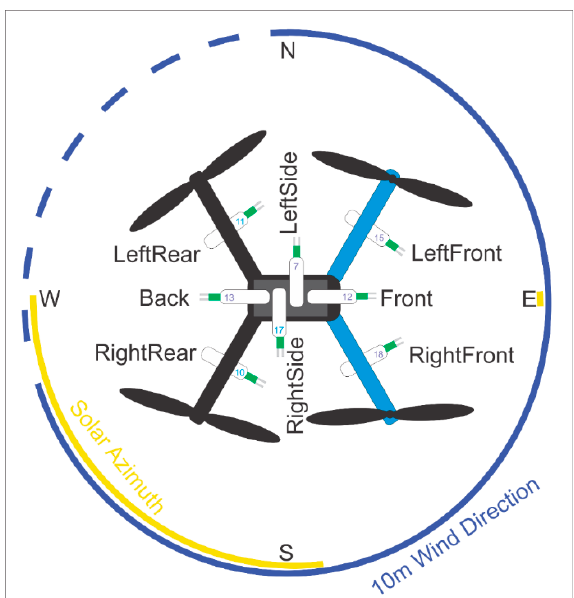
Figure 2. Schematic of the UAV in hover. Solar azimuth angles (yellow arc) range from 173.7 ◦ to 268.18 ◦ and from 88.87 ◦ to 89.87 ◦ . The 10 m wind direction ranges from 0 ◦ to 248.9 ◦ (solid blue arc) with interspersed observations (only 8 of them) between 262.3 ◦ and 356.6 ◦ degrees (dashed blue curve). (Note that the day when the solar angle ranged between 88.87 ◦ to 89.87 ◦ is missing). The Mesonet tower is to the north of the UAV. The iMET-XQ locations are numbered and named.